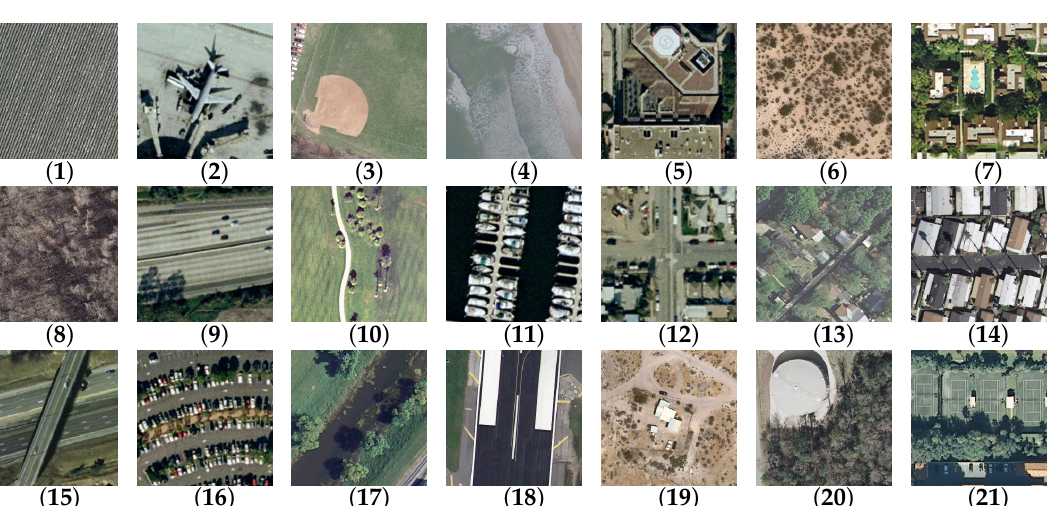
Figure 3. Sample images of the UCM dataset: ( 1 ) Agricultural, ( 2 ) Airplane, ( 3 ) Baseball diamond, ( 4 ) Beach, ( 5 ) Building, ( 6 ) Chaparral, ( 7 ) Dense residential, ( 8 ) Forest, ( 9 ) Freeway, ( 10 ) Golf course, ( 11 ) Harbor, ( 12 ) Intersection, ( 13 ) Medium residential, ( 14 ) Mobile-homepark, ( 15 ) Overpass, ( 16 ) Parking lot, ( 17 ) River, ( 18 ) Runway, ( 19 ) Sparse residential, ( 20 ) Storage tanks, ( 21 ) Tennis